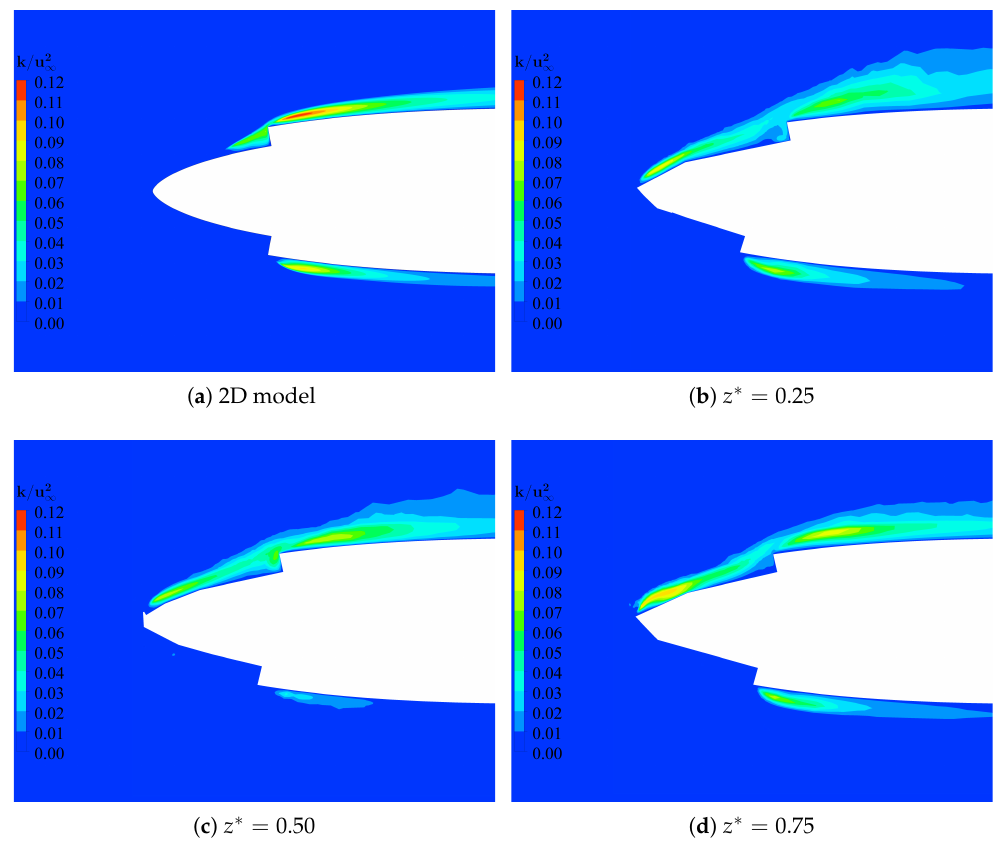
Figure 13. Comparison between contour plots of the non-dimensional turbulent kinetic energy around the 2D airfoil ( a ) and the 3D blade ( b – d ) at 4 ◦ incidence. ( a ) Turbulent kinetic energy contour around the two-dimensional airfoil; ( b – d ) turbulent kinetic energy contour around the three-dimensional blade on a xy plane passing through 1/4, 1/2, and 3/4 of the span,